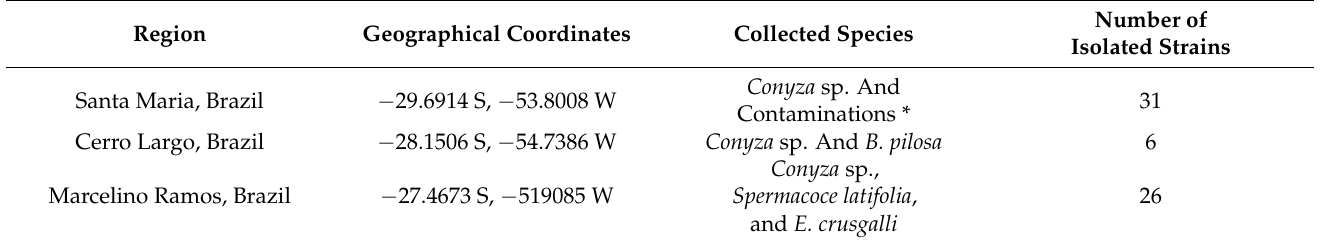
Table 1. Geographic coordinates, plants collected, and the number of microorganisms isolated for this study. Region Geographical Coordinates Collected Species